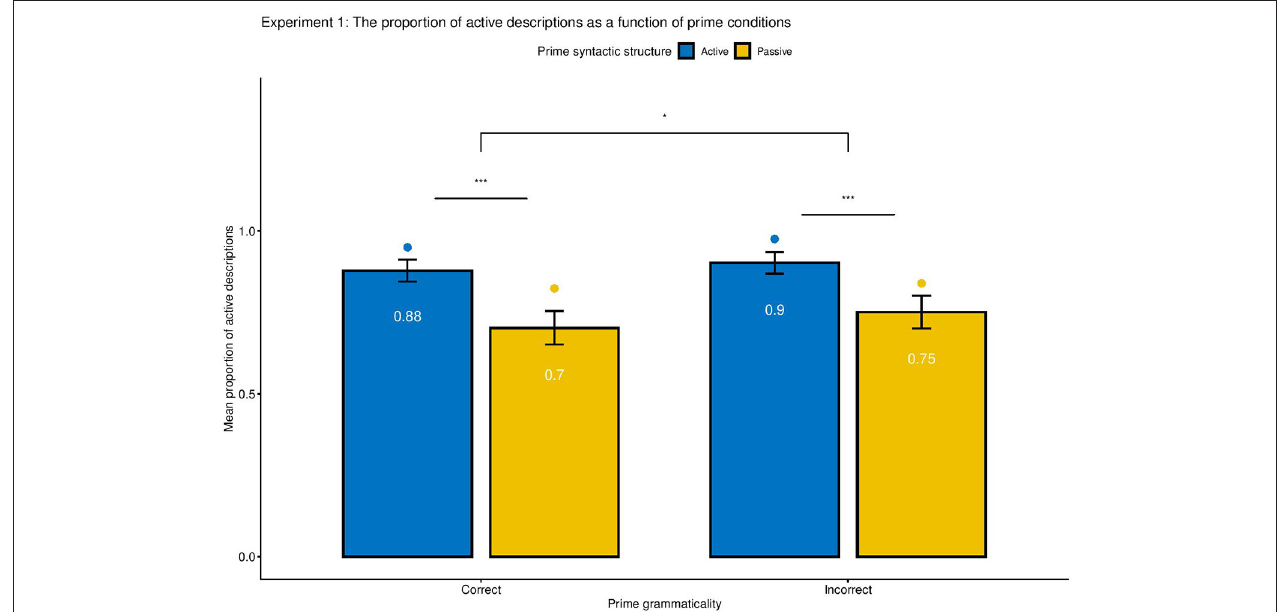
FIGURE 3 | Experiment 1: Mean proportion of producing active constructions as a function of prime grammaticality (Correct vs. Incorrect), syntactic voice (Active vs. Passive). The bar graph and the numbers within each bar represent the mean proportion of produced descriptions across participants, with error bars representing 95% confidence interval. The dot plot represents the estimated proportion transformed by mixed effect logistic model outputs. Asterisk indicates significance level (*** means p < 0.001, * indicates p < 0.05), and n.s. indicates non-significant results. No interaction between Syntactic Structure and Syntactic Correctness was found, z = − 0.6, p > 0.1. Significant priming effects were found controlling for syntactic correctness and semantic correctness, p < 0.01, and there were robust significant effects of grammaticality on the preferences of syntactic constructions, regardless of semantic correctness, p < = 0.05.